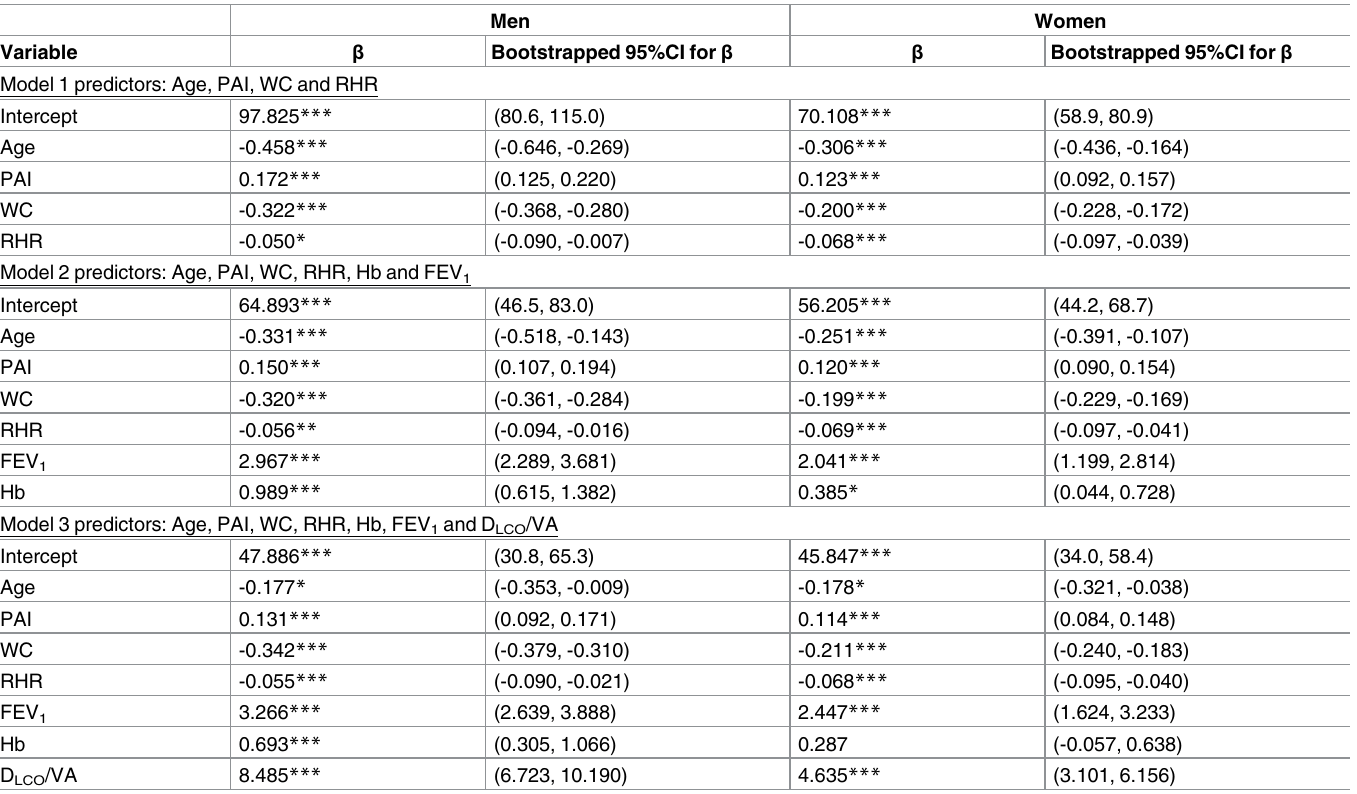
Table 3. Description of prediction